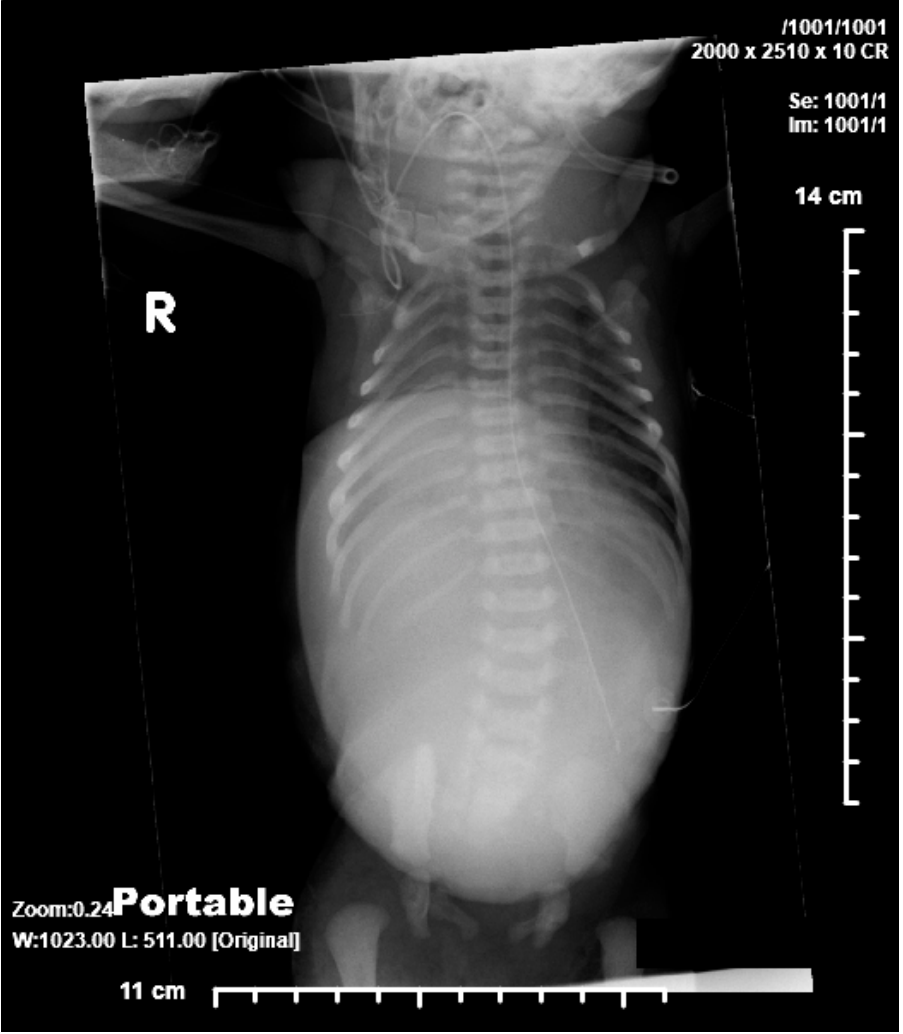
Figure 1. AP radiograph showing absence of lower part of sternum, large omphalocele, and suggestion of pulmonary hypoplasia.